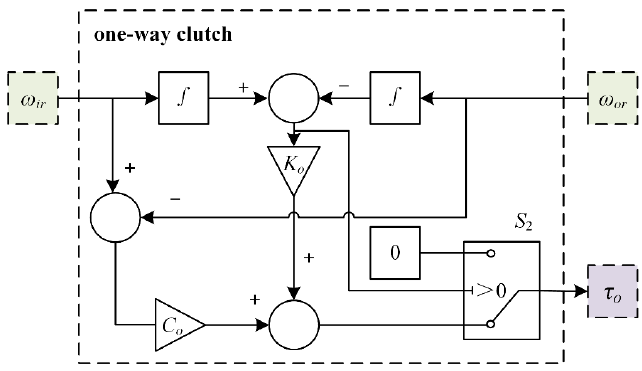
Figure 8. Block diagram of the angular displacement difference model.